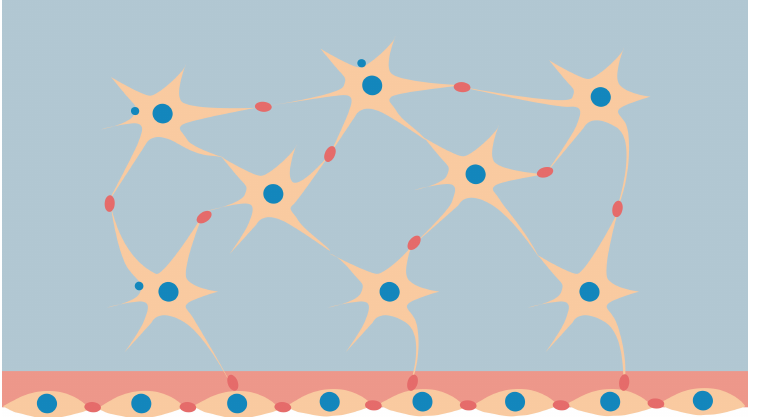
Figure 1. Osteocytes in bone matrix (star-shaped) with the formed OLCN connected to osteoblasts on the